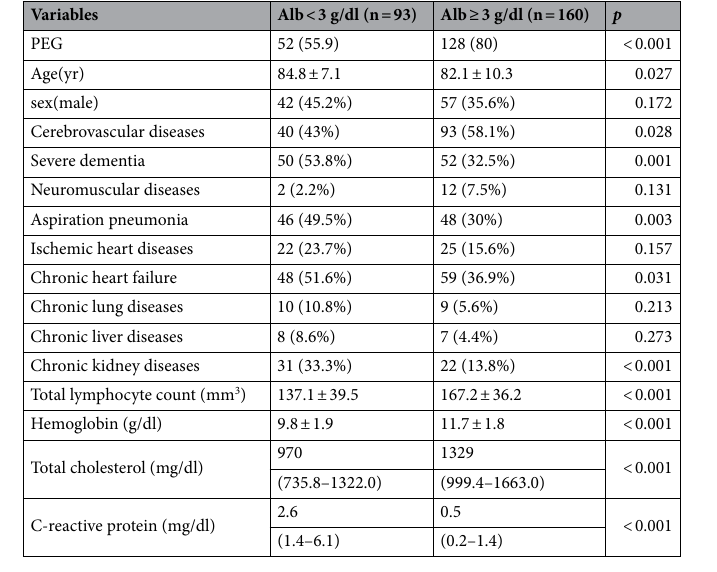
Table 1. Baseline characteristics of patients. Values of total cholesterol and C-reactive protein are median (IQR). Values of age, total lymphocyte, and hemoglobin are given in Mean ± Std. Values of other variables are given in numbers (%). PEG percutaneous endoscopic